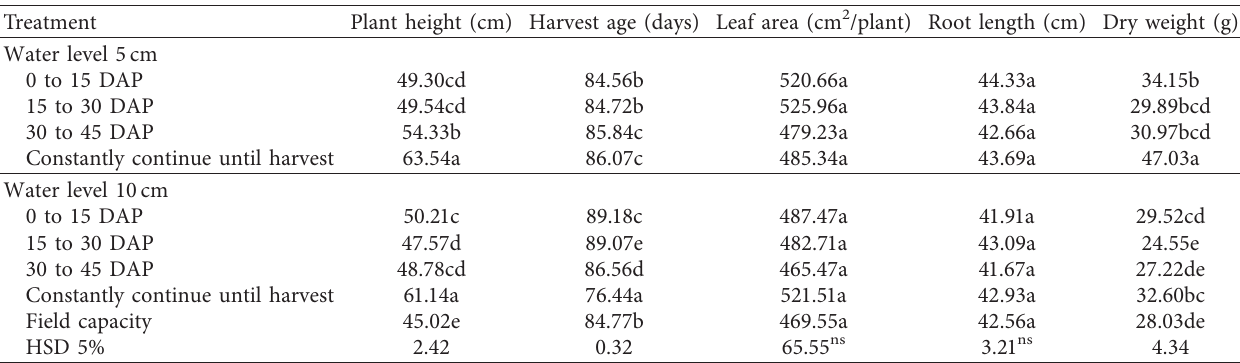
Table 2: Effect of water level and immersion time on plant height, harvest age, leaf area, root length, and dry weight of biomass at harvest. Treatment